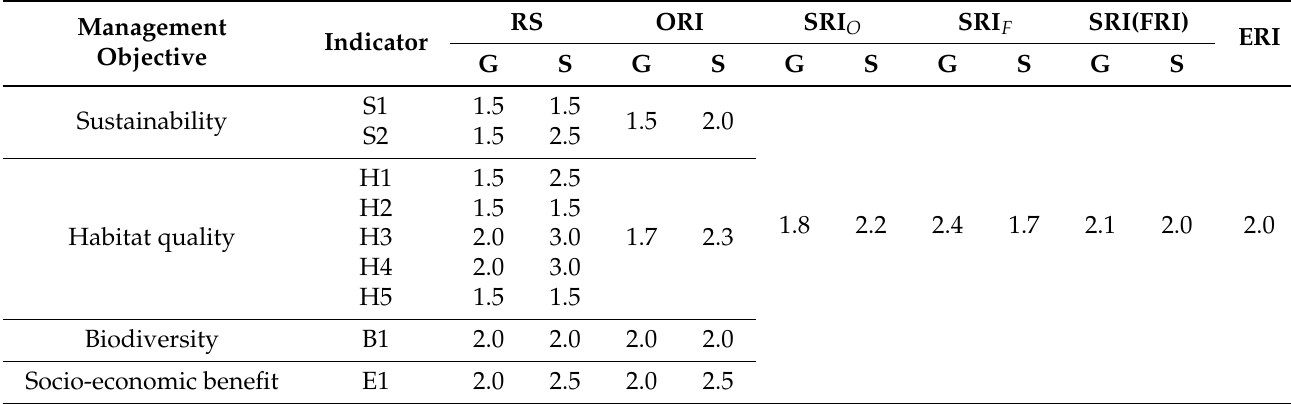
Table 3. The estimated risk scores and derived risk indices for Uljin coastal waters from the extended EBFA approach (RS: risk score for each indicator, ORI: objective risk index for each management objective, SRI O : species risk index by other driving forces, SRI F : species risk index by capture fishery, SRI:species risk index incorporating other driving forces and capture fishery, FRI: fishery risk index, ERI: ecosystem risk index, G: gillnet fishery, and S: set net